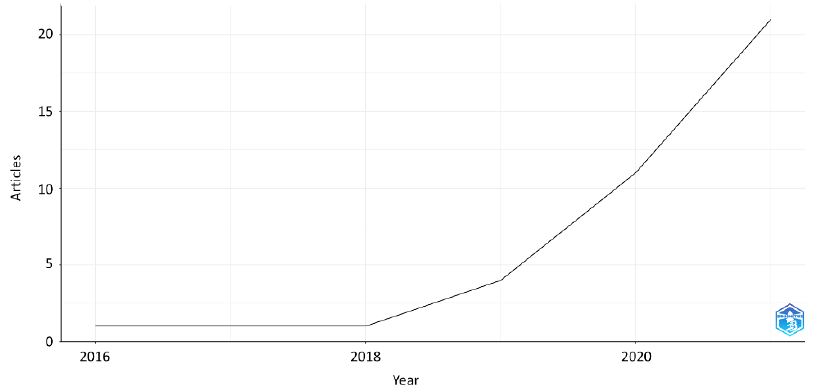
Figure 2. Annual Scientific Production of the publications mentioning use of NIR technology to analyse MPs. The plot was generated using the open-source tool Biblioshiny for Bibliometrix [38]. Table 2. Average number of citations received by analysis of MPs with FTIR and NIR papers per year.